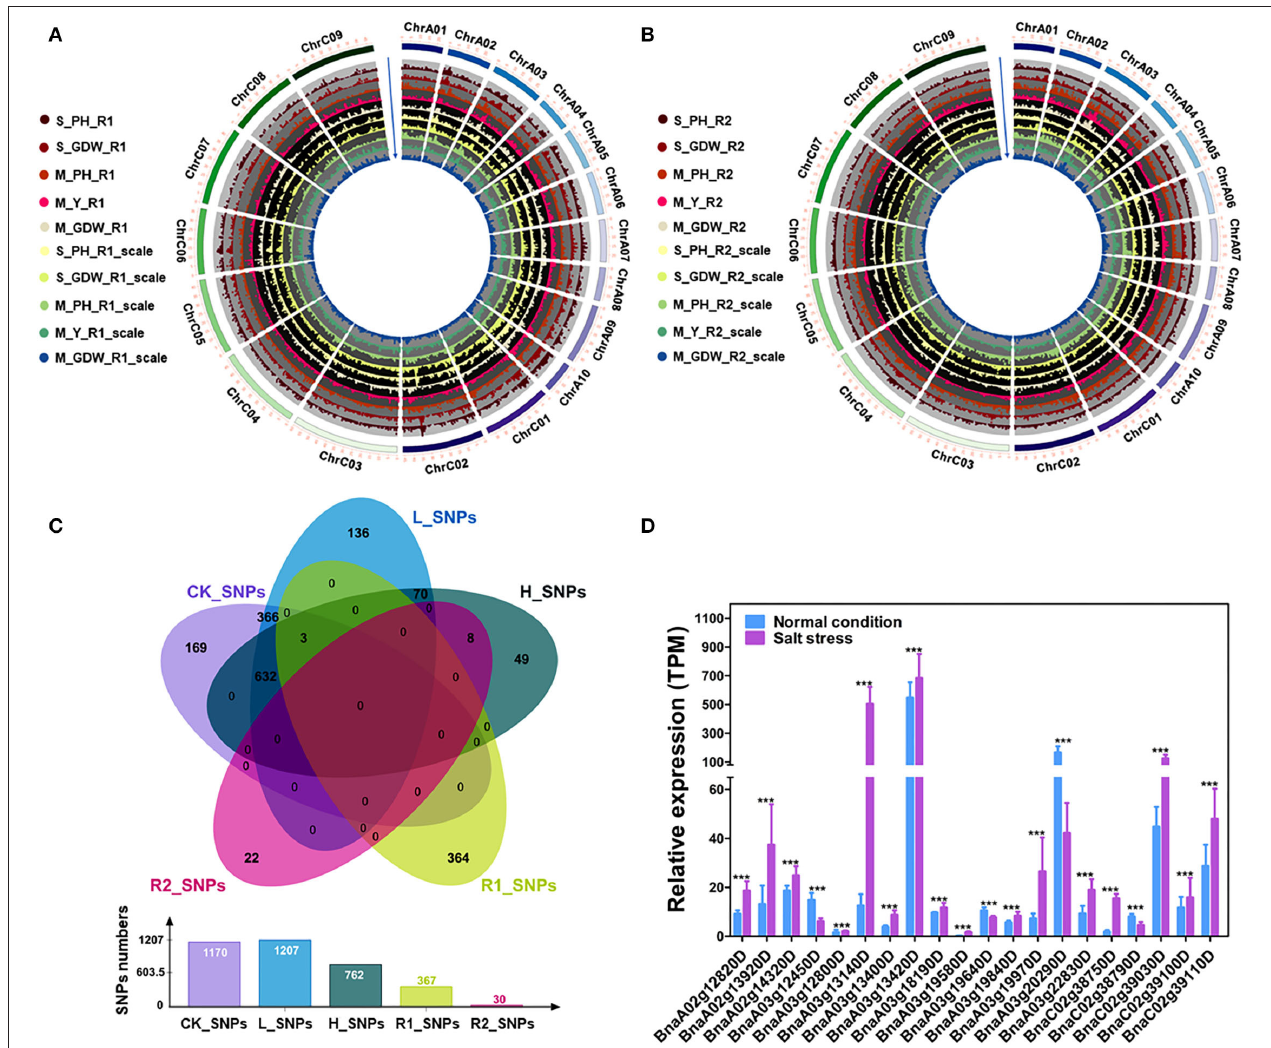
FIGURE 3 | GWAS for tolerance coefficients (TCs) and identification of candidate genes. (A) Circle Manhattan plots with the co-localized SNPs for TCs of multiple traits under low salt-alkali condition ( P ≤ 1e-2). S_PH_R1, the ratio of plant height between low salt-alkali and control conditions at the seedling stage; S_GDW_R1, the ratio of ground dry weight between low salt-alkali and control conditions at the seedling stage; M_PH_R1, the ratio of plant height between low salt-alkali and control conditions at the mature stage; M_Y_R1, the ratio of yield between low salt-alkali and control conditions at the mature stage; M_GDW_R1, the ratio of ground dry weight between low salt-alkali and slight control conditions at the mature stage; S_PH_R1_scale, normalized value of the plant height ratio between low salt-alkali and control conditions in the seedling stage; S_GDW_R1_scale, normalized value of the ground dry weight ratio between low salt-alkali and control conditions; M_PH_R1_scale, normalized value of the plant height ratio between low salt-alkali and control conditions at the mature stage; M_Y_R1_scale, normalized value of the yield ratio between low salt-alkali and control conditions at the mature stage; M_GDW_R1_scale, normalized value of the ground dry weight ratio between low salt-alkali and control conditions at mature the stage. (B) Circle Manhattan plots with the co-localized SNPs for TCs of multiple traits under the high-salt-alkali condition ( P ≤ 1e-2). S_PH_R2, the ratio of plant height between high salt-alkali and control conditions at the seedling stage; S_GDW_R2, the ratio of ground dry weight between high-salt-alkali and control conditions at the seedling stage; M_PH_R2, the ratio of plant height between high-salt-alkali and control conditions at the mature stage; M_Y_R2, the ratio of yield between high-salt-alkali and control conditions at the mature stage; M_GDW_R2, the ratio of ground dry weight between high-salt-alkali and control conditions at the mature stage; S_PH_R2_scale, the ratio of normalized value of plant height between high-salt-alkali and control conditions at the seedling stage; S_GDW_R2_scale, the ratio of normalized value of ground dry weight between high-salt-alkali and control conditions at the seedling stage; M_PH_R2_scale, the ratio of normalized value of plant height between high-salt-alkali and control conditions at the mature stage; M_Y_R2_scale, the ratio of normalized value of yield between high-salt-alkali and control conditions at the mature stage; M_GDW_R2_scale, the ratio of normalized value of ground dry weight between high-salt-alkali and control conditions at the mature stage. (C) Co-localized SNPs under different environmental conditions revealed by Venn analysis. CK_SNPs, candidate SNPs of all traits under the control condition; L_SNPs, candidate SNPs of all traits under the low-salt-alkali condition; H_SNPs, candidate SNPs of all traits under high-salt-alkali conditions; R1_SNPs, candidate SNPs of all TCs under the low-salt-alkali condition; R2_SNPs, candidate SNPs of all TCs under the high-salt-alkali condition. The bar graph represents the number of SNPs under each environmental condition. (D) Gene expression of candidate differential expressed genes (DEGs) under salt stress condition. Statistical significance was determined by Student’s T -test. *** p < 0.001.